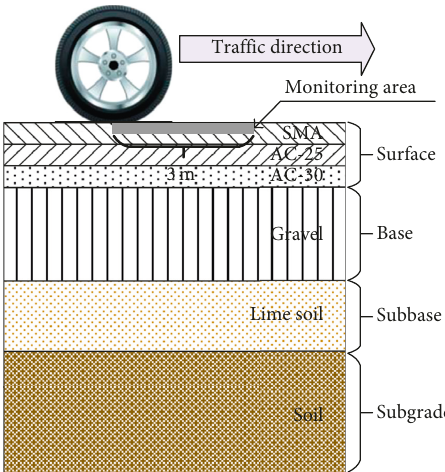
Figure 10: The monitoring area.